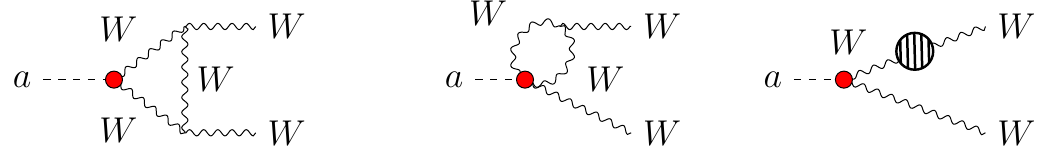
˜ W interaction. The blob in the charged fermion contributions (a similar contribution L